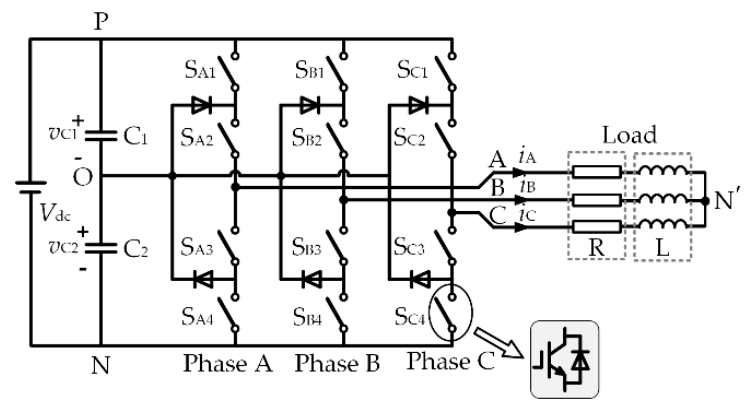
Figure 1. The topology of the NPC three-level inverter.